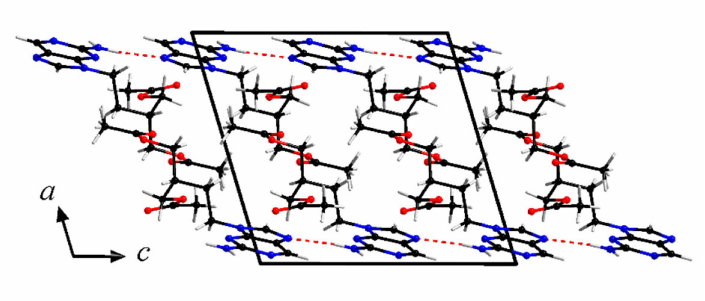
Figure 7. Crystal structure of anhydrous famciclovir (form I). View along cell axis b . Hydrogen bond interactions are shown as red dotted lines.